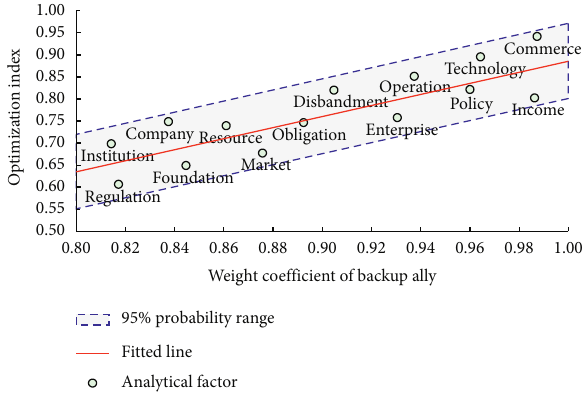
Figure 4: Relationship between optimization indexes and weight coefficients of backup